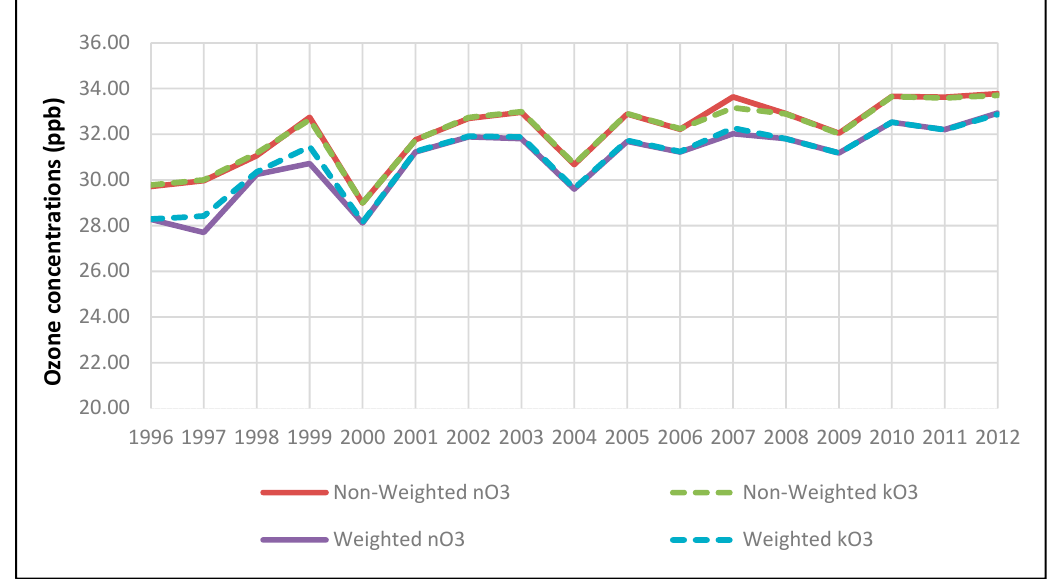
Figure 3. Trends in ozone concentrations in ppb: ( a ) solid lines for non-imputed ozone (nO3), non-weighted (red) versus weighted (purple); ( b ) dashed lines for imputed ozone (kO3), non-weighted (green) versus weighted (blue).